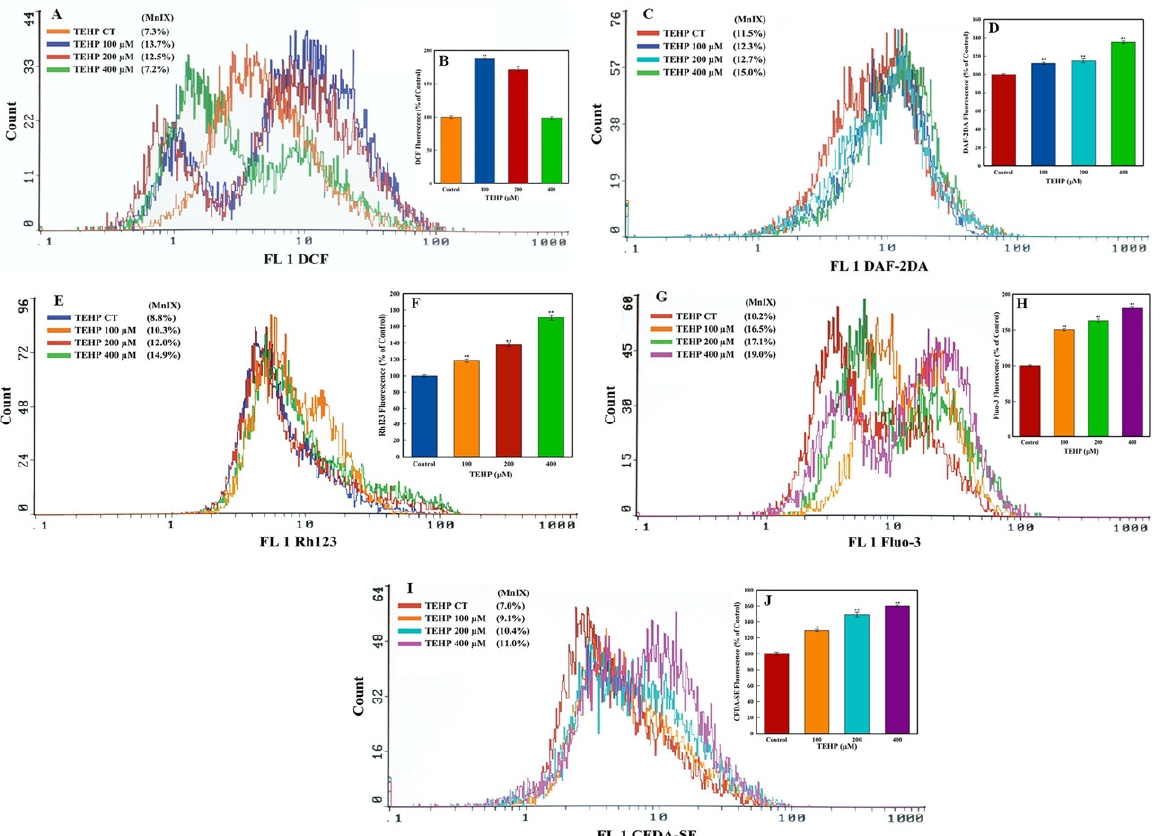
Figure 2. Flow cytometric quantification on intracellular ( A ) ROS, ( C ) NO, ( E ) ∆ Ψ m , ( G ) Ca ++ influx, and ( I ) esterase levels in HepG2 cells after 72 h of exposure at different concentrations of TEHP. MnIX: mean intensity of dye on the X -axis. Histograms in the subfigures ( B , D , F , H , J ) are plotted from the mean ± SD of MnIX obtained from three independent experiments carried out in triplicate wells (* p < 0.05, ** p < 0.01 versus control).